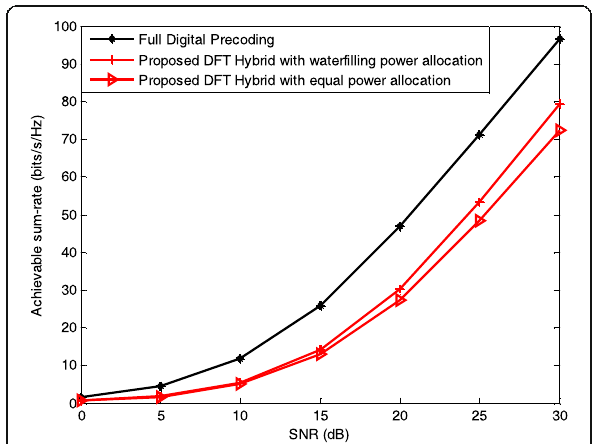
Fig. 7 The achievable sum rate vs. SNR with different power allocation